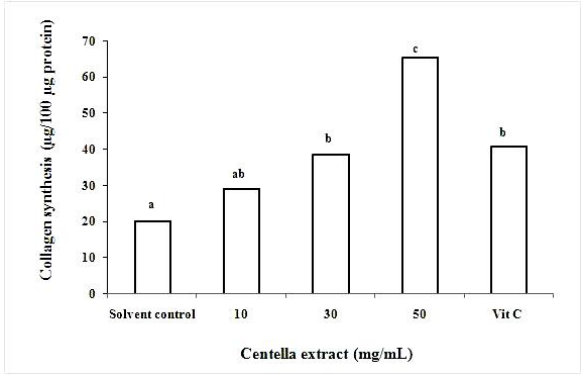
Figure 2. Stimulation of collagen synthesis of fibroblast cells using different concentration of Centella extracts (mg/mL) and vitamin C (25 µg/mL) was used as positive control. Untreated solvent was used as control. All fibroblast were incubated at 5% CO incubation. Values are the mean ± SD (n = 3). Values with different letter are significant different at P < 0.05